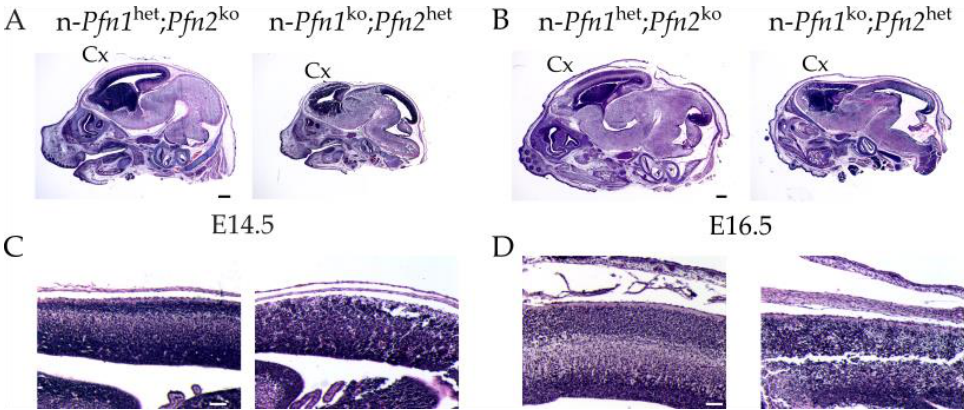
Figure 3. Histological analysis of single profilin 1 and single profilin 2 allele embryos. ( A ) A sample H&E-stained sagittal section of single Pfn1 allele (n- Pfn1 het ; Pfn2 ko ) embryo head at E14.5 shows no developmental defects, while a sample section from single Pfn2 allele (n- Pfn1 ko ; Pfn2 het ) embryo head shows reduced size, similarly to the n-dko genotype, and less compact tissue, even though development does not appear completely impaired. ( B ) Sample H&E-stained sagittal section of single Pfn1 allele E16.5 embryo head shows normal development, while the single Pfn2 allele embryos appear strongly affected, with a collapsing forebrain and reduced mid-/hindbrain size. ( C ) Cortical layering at E14.5 is not affected in n- Pfn1 het ; Pfn2 ko embryos, while it is completely disrupted in n- Pfn1 ko ; Pfn2 het embryos, similarly to n-dko embryos (see Figure 2F). ( D ) The cortex at E16.5 shows perfect layering in single Pfn1 allele embryos, but is disordered in single Pfn2 allele embryos. Scale bars: 1 mm in ( A , B ); 200 μ m in ( C , D ).